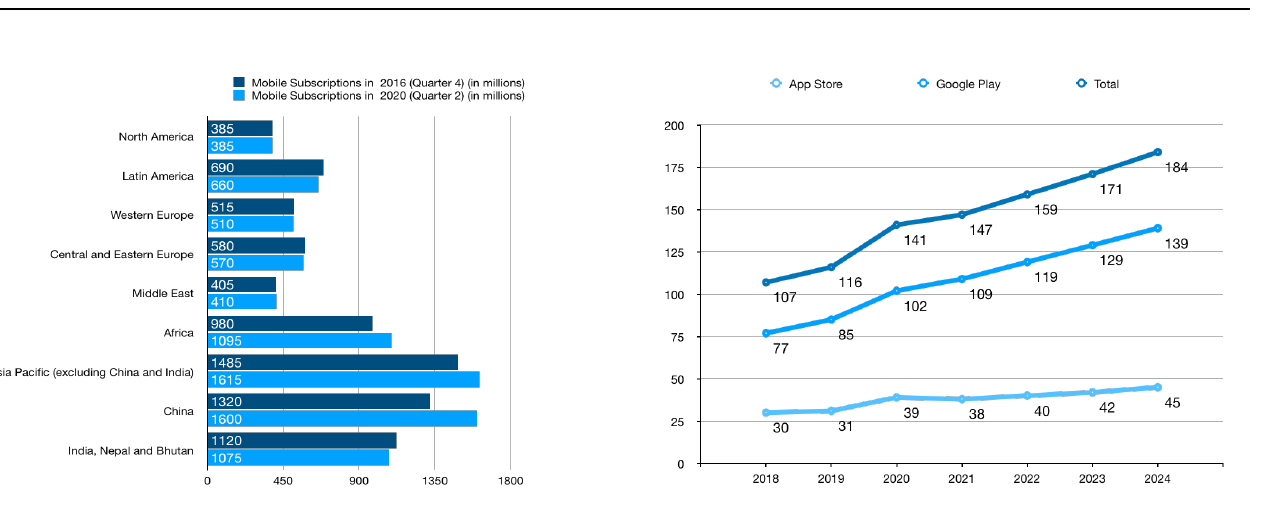
Figure 1. A region wise comparison of mobile subscriptions